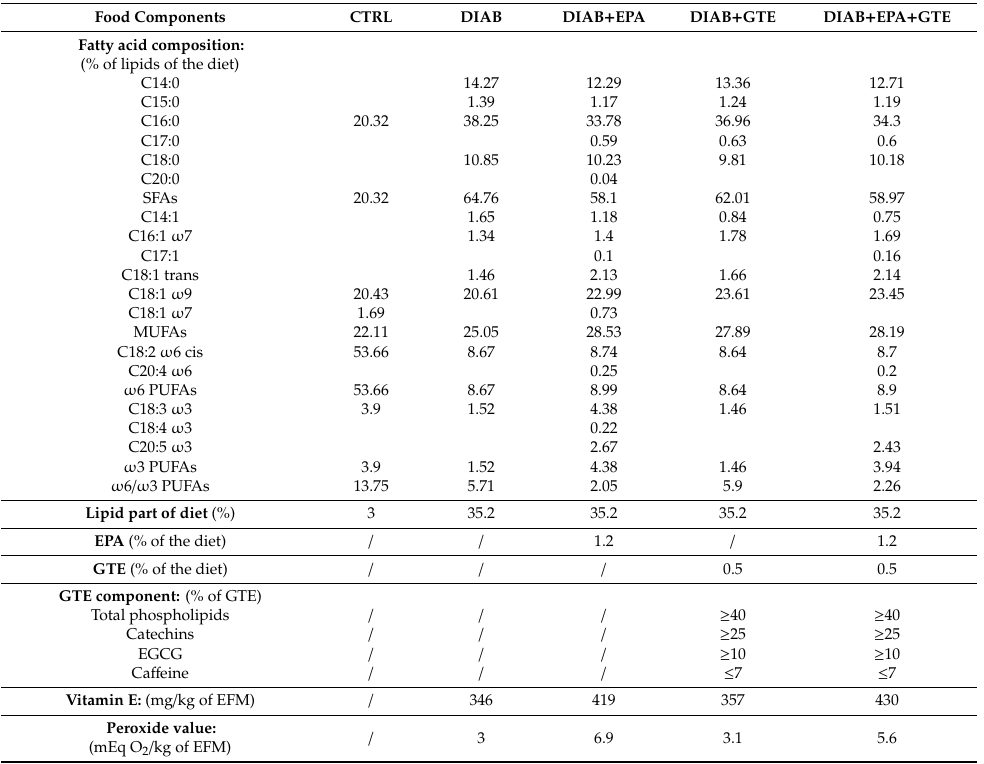
Table 1. Composition of the diets. Food Components CTRL